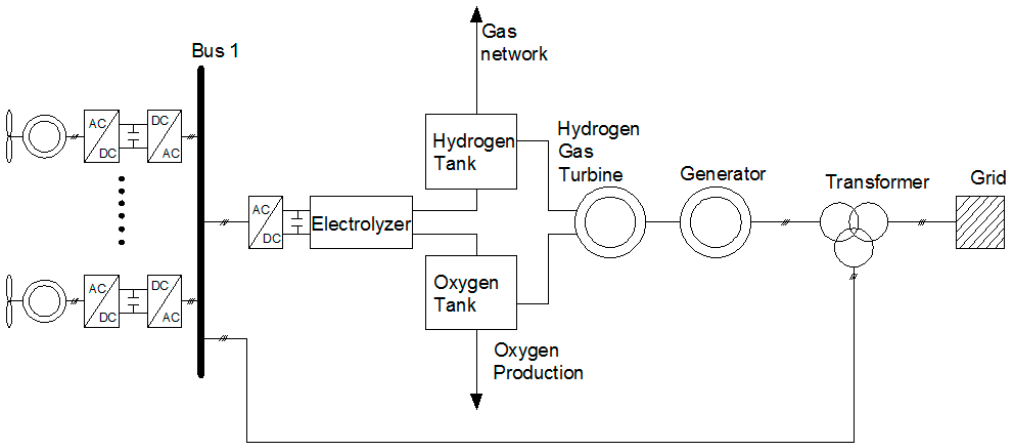
Figure 1. The system configuration.